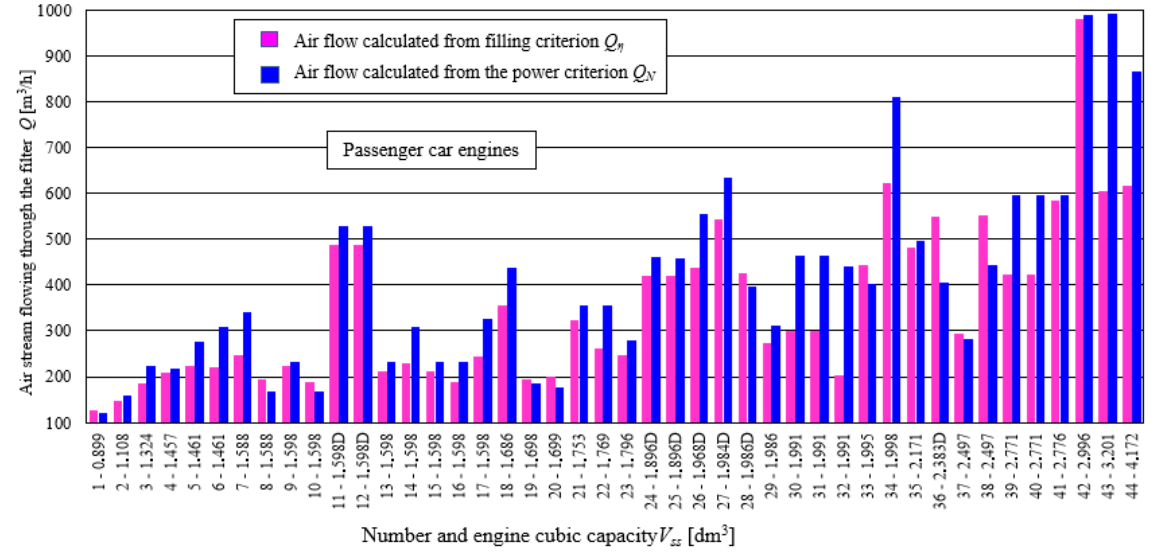
Fig. 6. Nominal air stream Q η , Q N values flowing through the filter elements in engine filters of different